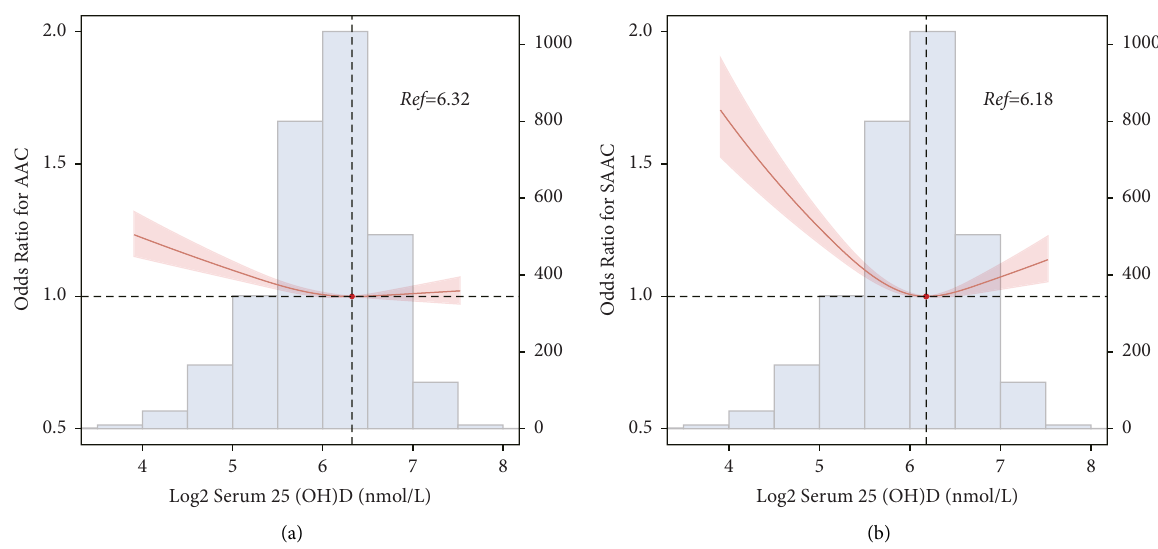
Figure 1: Restricted cubic spline plot of the association between serum 25(OH)D and the risk of AAC (a) and SAAC